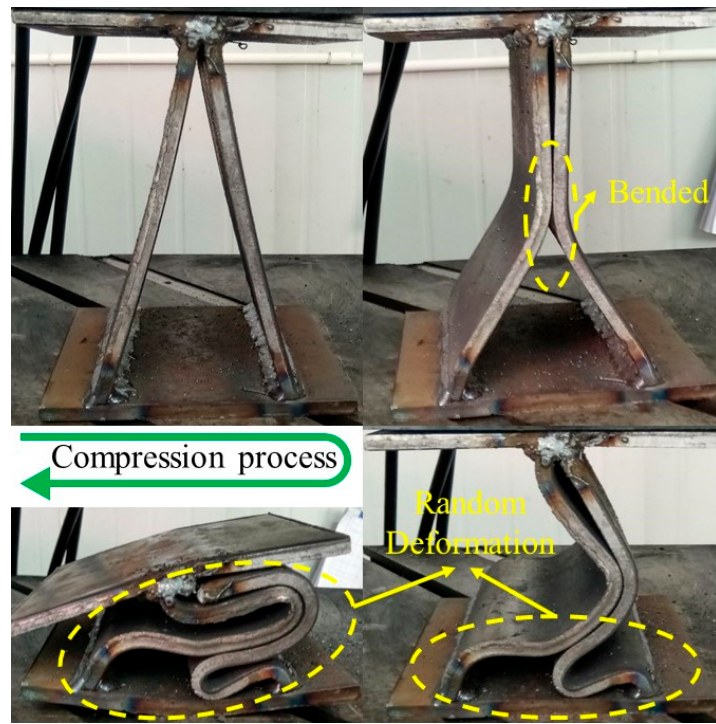
Figure 10. The compression-deformation process of the AED-II.